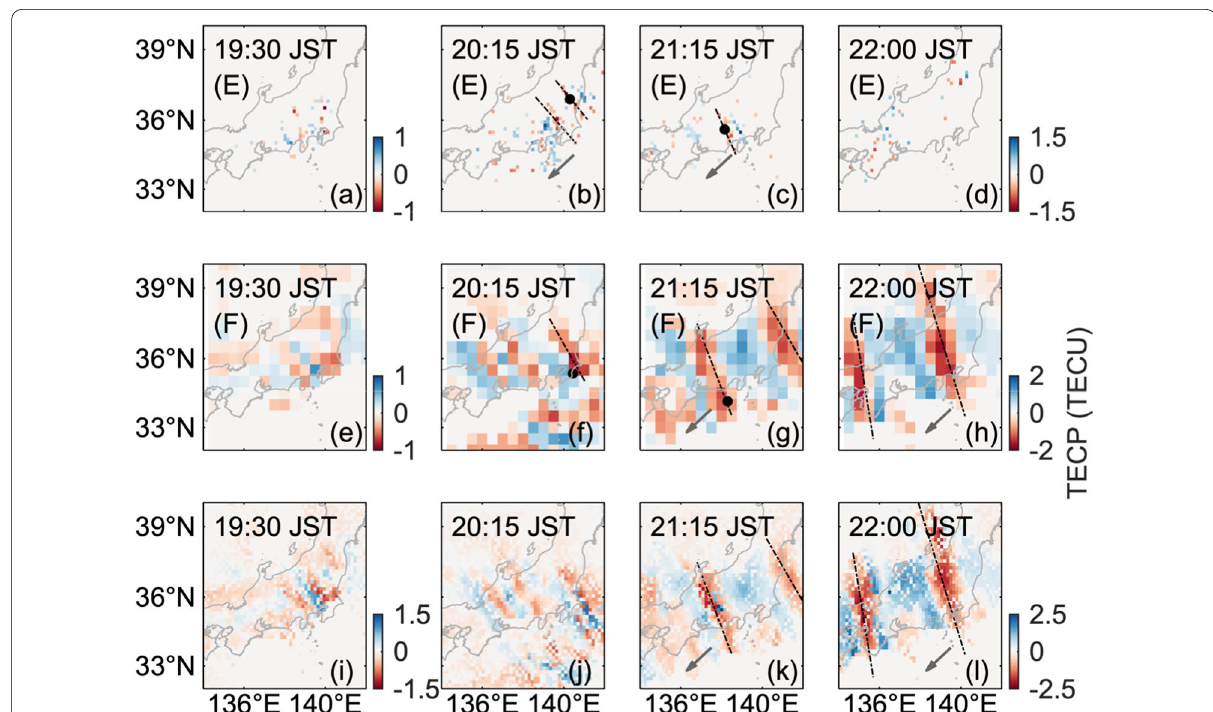
Fig. 6 Snapshots of TECP maps at E- ( a – d ) and F-shell heights ( e – h ), at various time epochs from 19:30 to 22:00 JST on 23 June 2012 (DOY 175). The subplots in the bottom ( i – l ) show the 2-D TECP maps obtained by the single-thin-shell approach. Black dashed lines indicate the alignment azimuth of the apparent frontal structures, gray arrows indicate the drift direction, black dots indicate the locations at E and F shells connected by the geomagnetic field